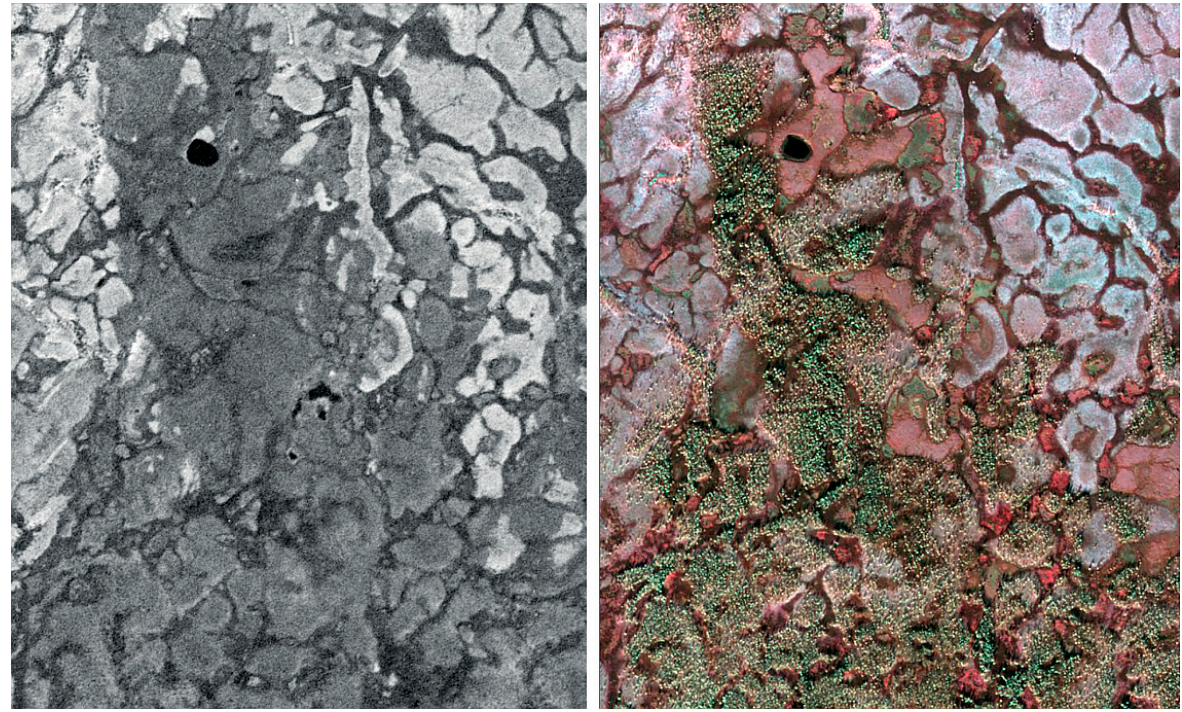
Figure 8. Afforestation of a burned tundra area in northern West Siberia. The left image was taken by Corona/KH-4b, 21 August 1968, the right image by Resurs-P, 28 September 2016. Source: